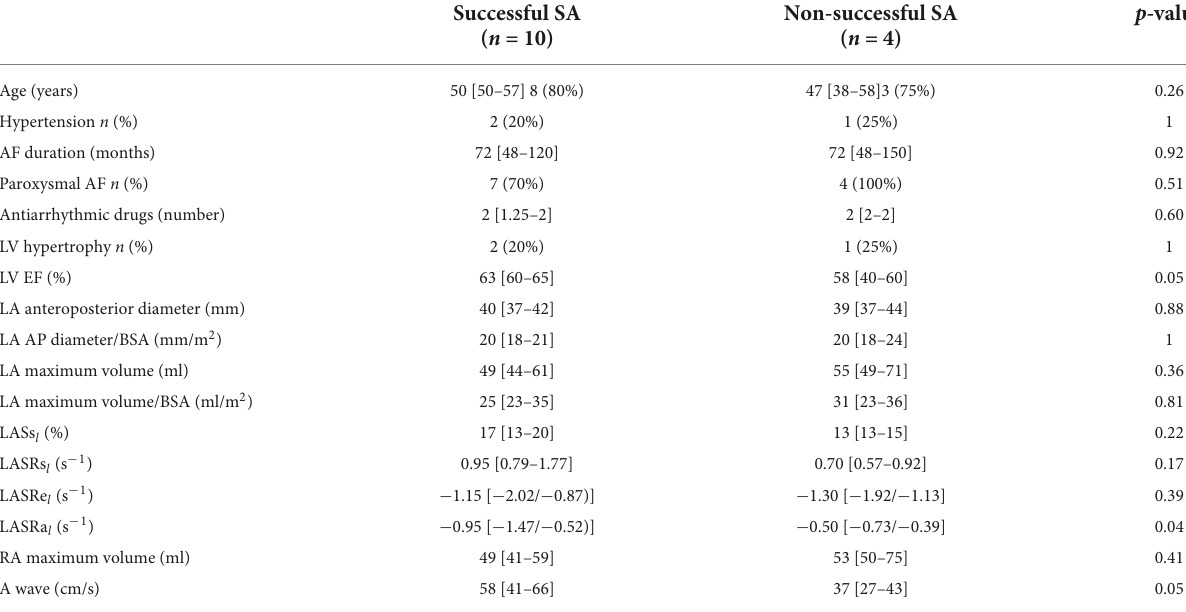
TABLE 3 Baseline characteristics of patients undergoing SA according to the success of the